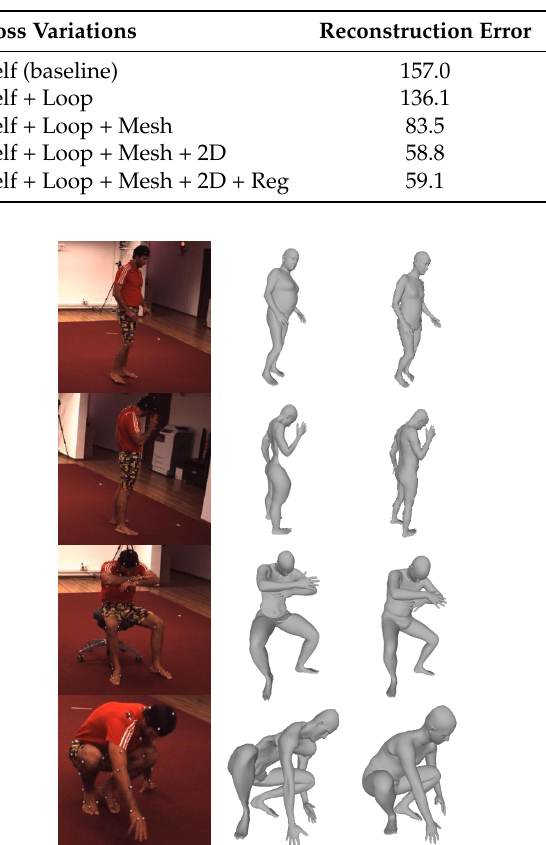
Table 4. Ablation experiments with various combinations of losses. The numbers denote reconstruction errors in mm.